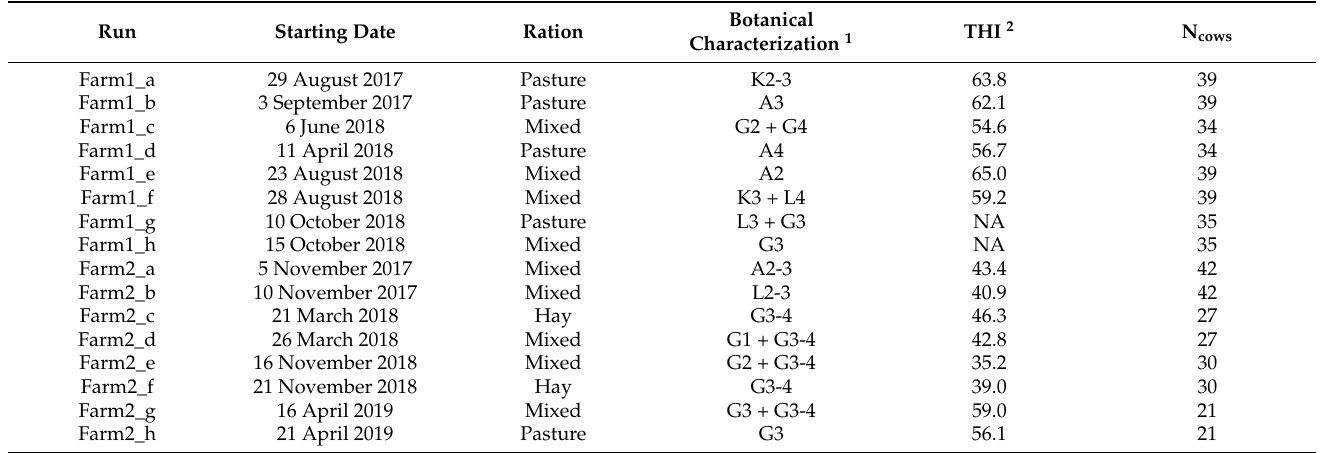
Table 1. Experimental setup showing the eight runs per farm, starting date, ration including botanical characterization, Temperature–Humidity Index (THI) and number of cows involved.